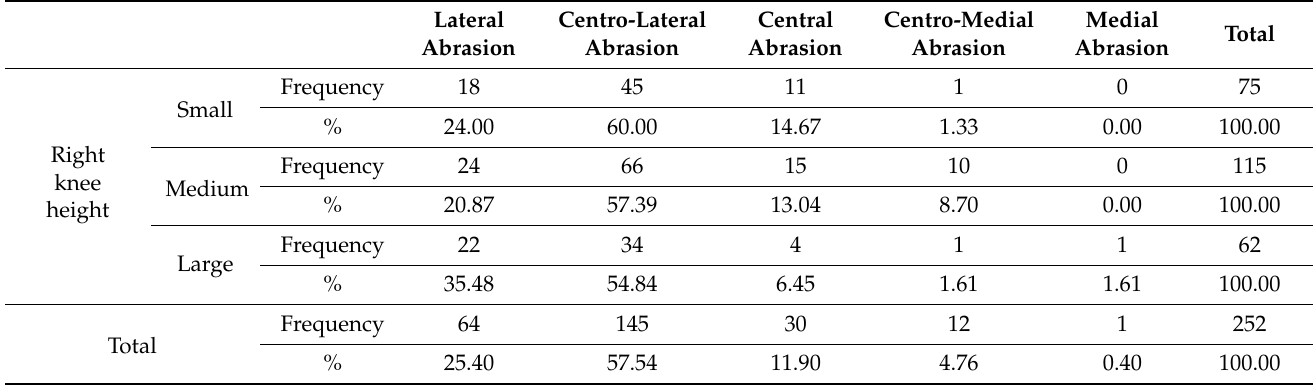
Table 13. Relationship between the right knee height and left shoe abrasion pattern (X 2 = 15.72, df = 8, p =